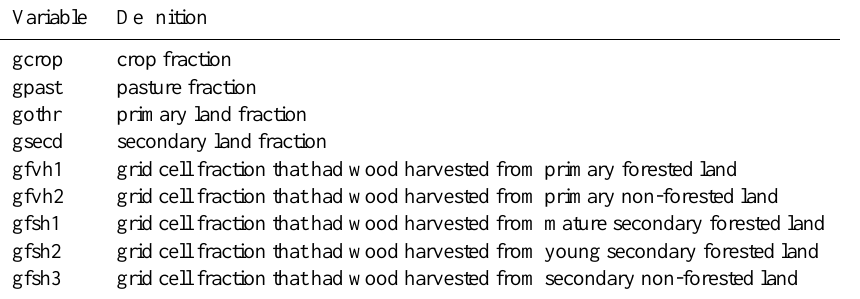
Table 2. Fields output by